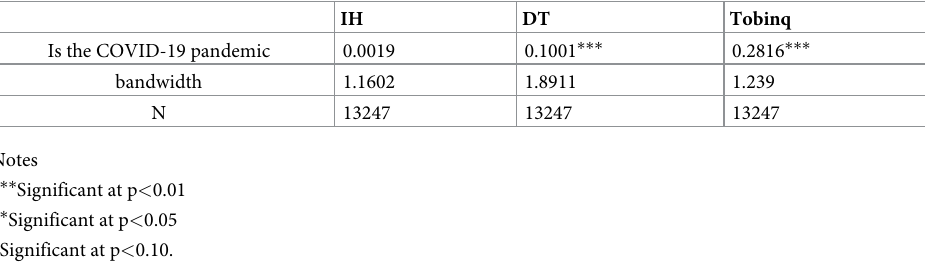
Table 11. Regression discontinuity